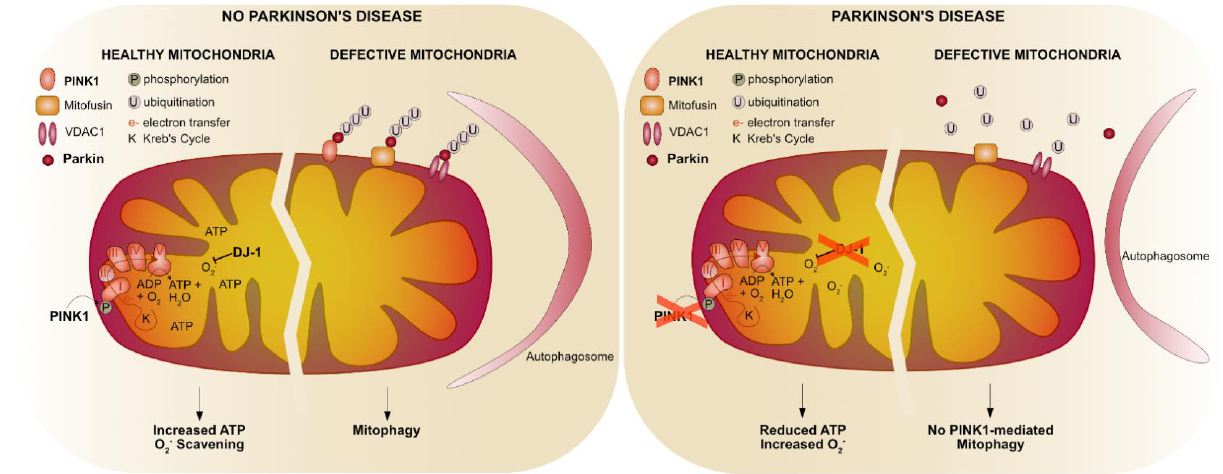
Figure 2. PD-related proteins in mitochondrial function. In healthy mitochondria, complex I of the electron transport chain (ETC) is phosphorylated in a Pink1-dependent fashion resulting in an efficient electron transfer through the different ETC complexes to finally use oxygen and ADP to form ATP. Oxidative stress (O 2. ) created by the ETC is scavenged by DJ-1. Upon a defective mitochondrial membrane potential Pink1 remains at the outer mitochondrial membrane that provides a signal for the translocation of Parkin to the mitochondria to ubiquitinate mitochondrial proteins to label these defective mitochondria for autophagosomal degradation. In genetic forms of PD, a lack of PINK1 prevents the phosphorylation of complex I that leads to an inefficient electron transfer and thus a decrease in ATP production. Furthermore, due to loss of PINK1, Parkin is not translocated to the mitochondria resulting in a lack of ubiquitination of mitochondrial proteins to label mitochondria for degradation. Loss of DJ-1 results in increased oxidative stress that results in dysfunctional